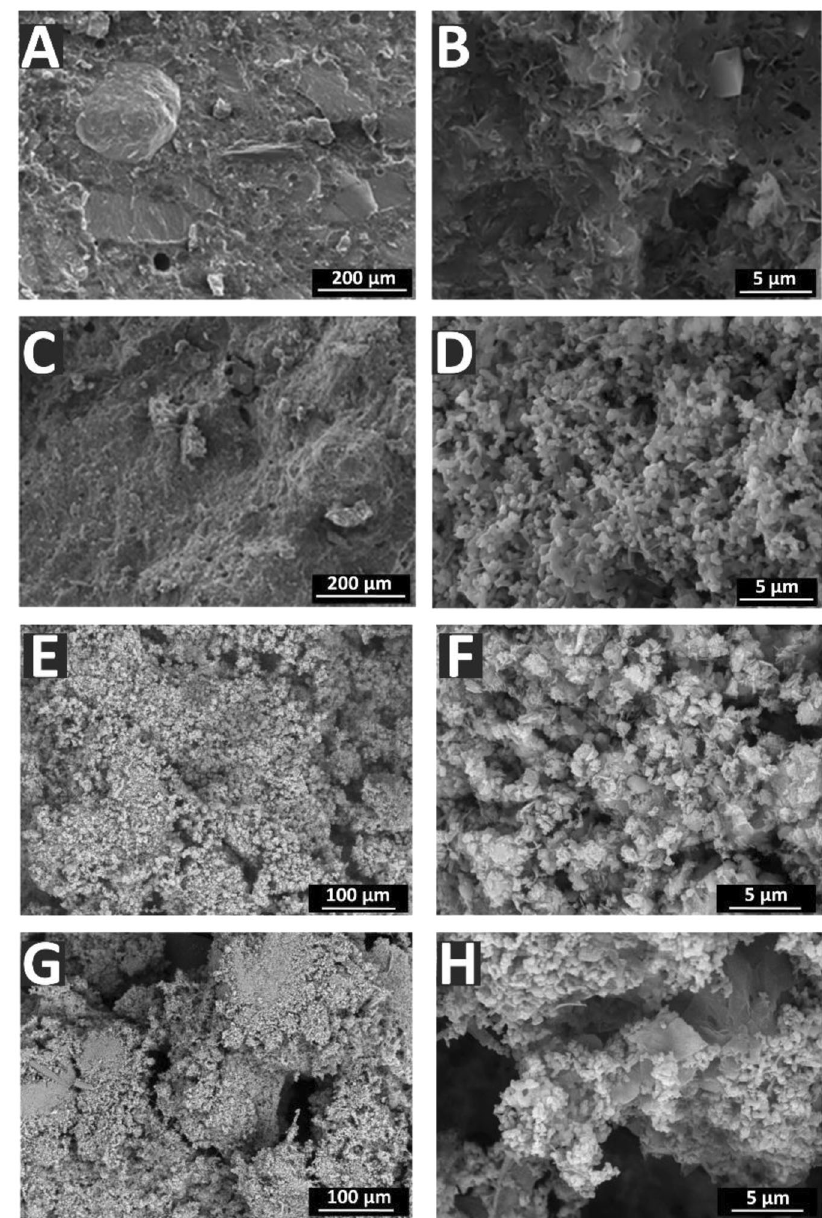
Fig. 5 Cements ’ morphology: A , B cement based on β -TCP; C , D cement based on Zn- β -TCP; E , F cement based on β -TCP after soaking in physiological solution; G , H cement based on Zn- β -TCP after soaking in physiological